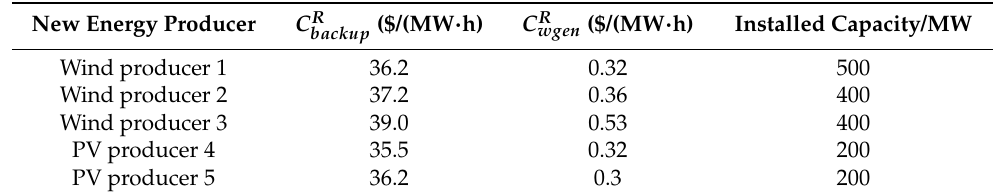
Table 1. Unit operating parameters.